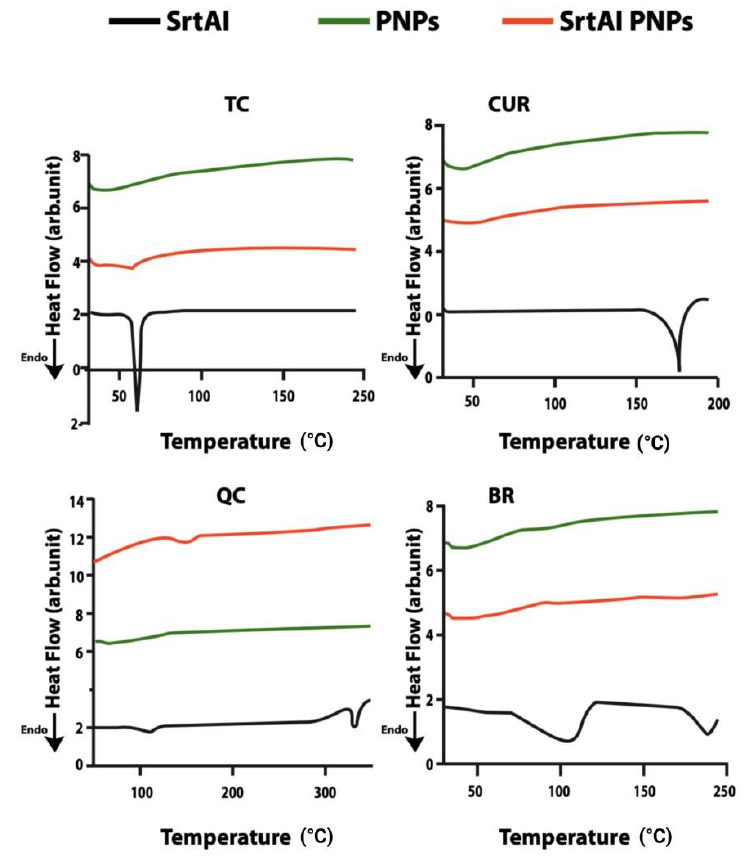
Figure 3. DSC thermograms for each SrtAI (TC, CUR, QC, BR), as well as SrtAI-loaded and empty β -LG PNPs. ‘arb. unit’ indicates arbitrary units.